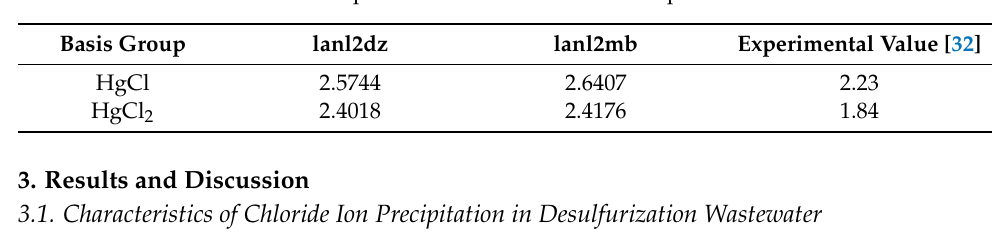
Table 3. lanl2dz and lanl2mb comparison of the calculated and experimental values of the basis